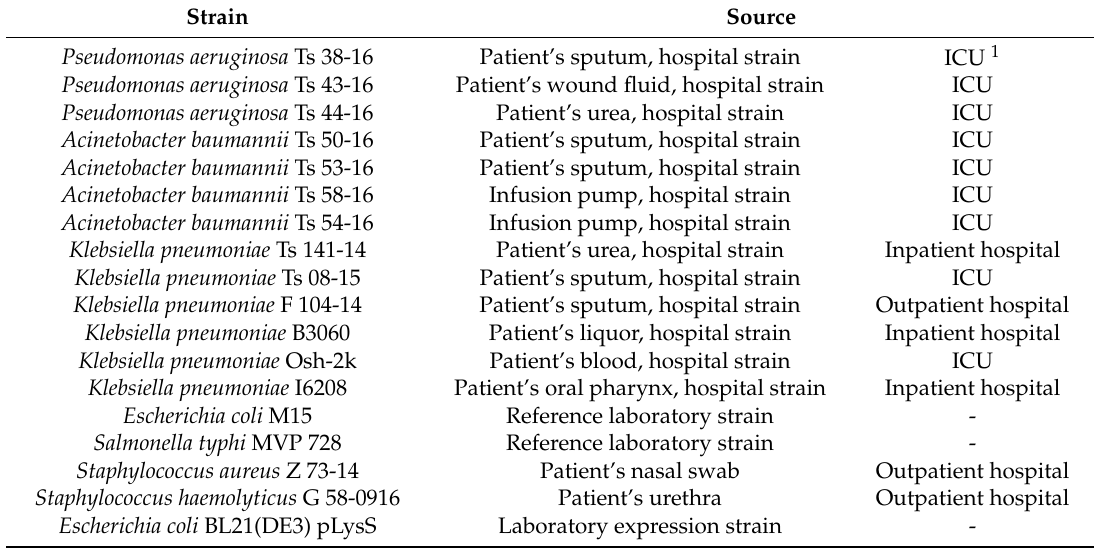
Table 1. Bacterial strains used in the study and the sources of their isolation.